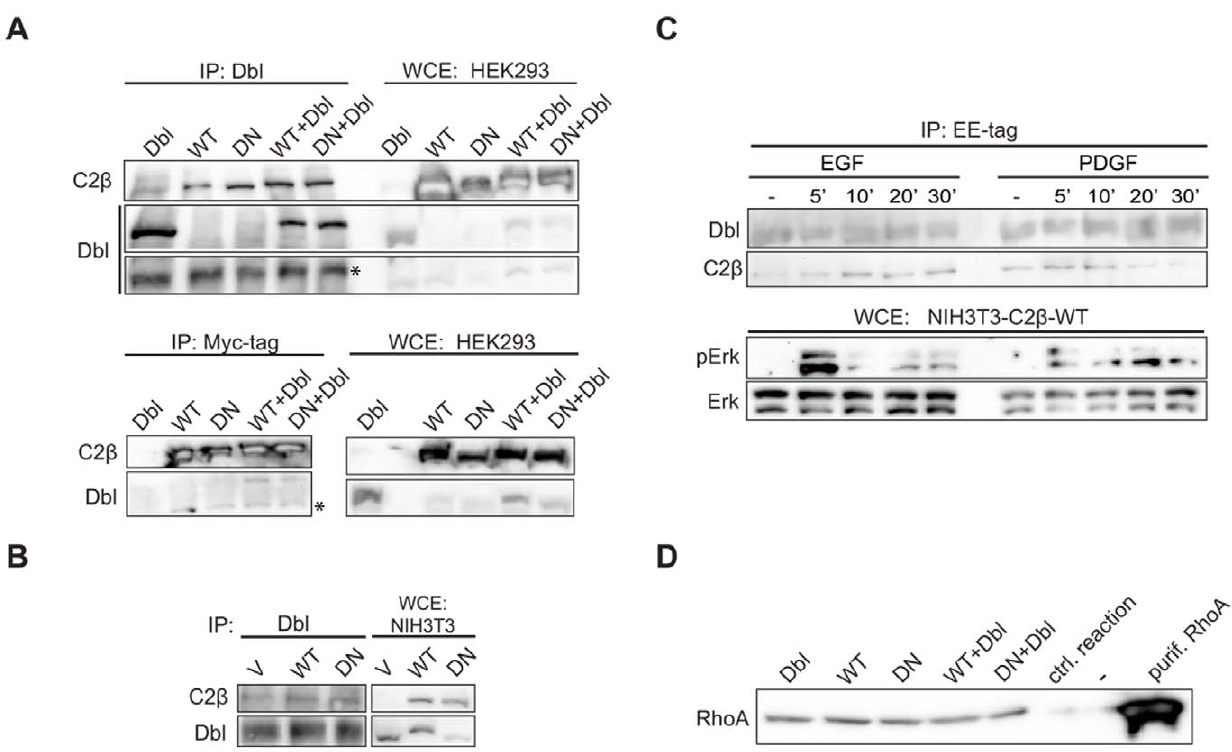
Figure 5. The assembly of the Dbl - PI3KC2 b complex is not modulated by PI3K activity or cell stimulation with EGF or PDGF. (A) HEK293 cells were transfected with vectors encoding Dbl in combination with Myc-PI3KC2 b WT or DN, or empty vector. Immunoprecipitates prepared with anti-Dbl or anti-Myc tag antibodies were analysed by western blot with the antibodies indicated. (B) Lysates from NIH3T3-V, -C2 b -WT or -C2 b -DN cells were immunoprecipitated with anti-Dbl antibodies and analysed by western blot. (C) Serum-starved NIH3T3-C2 b -WT cells were stimulated with EGF (20 ng/ml) or PDGF (20 ng/ml) for the indicated lengths of time. Immunoprecipitates prepared with anti-Glu (EE) tag antibodies were analysed by western blot with the antibodies indicated. (D) HEK293 cells were transfected with vectors encoding Dbl in combination with Myc- PI3KC2 b WT or DN, or empty vector. Immunoprecipitates prepared with anti-Dbl antibodies were analysed for GEF activity towards recombinant